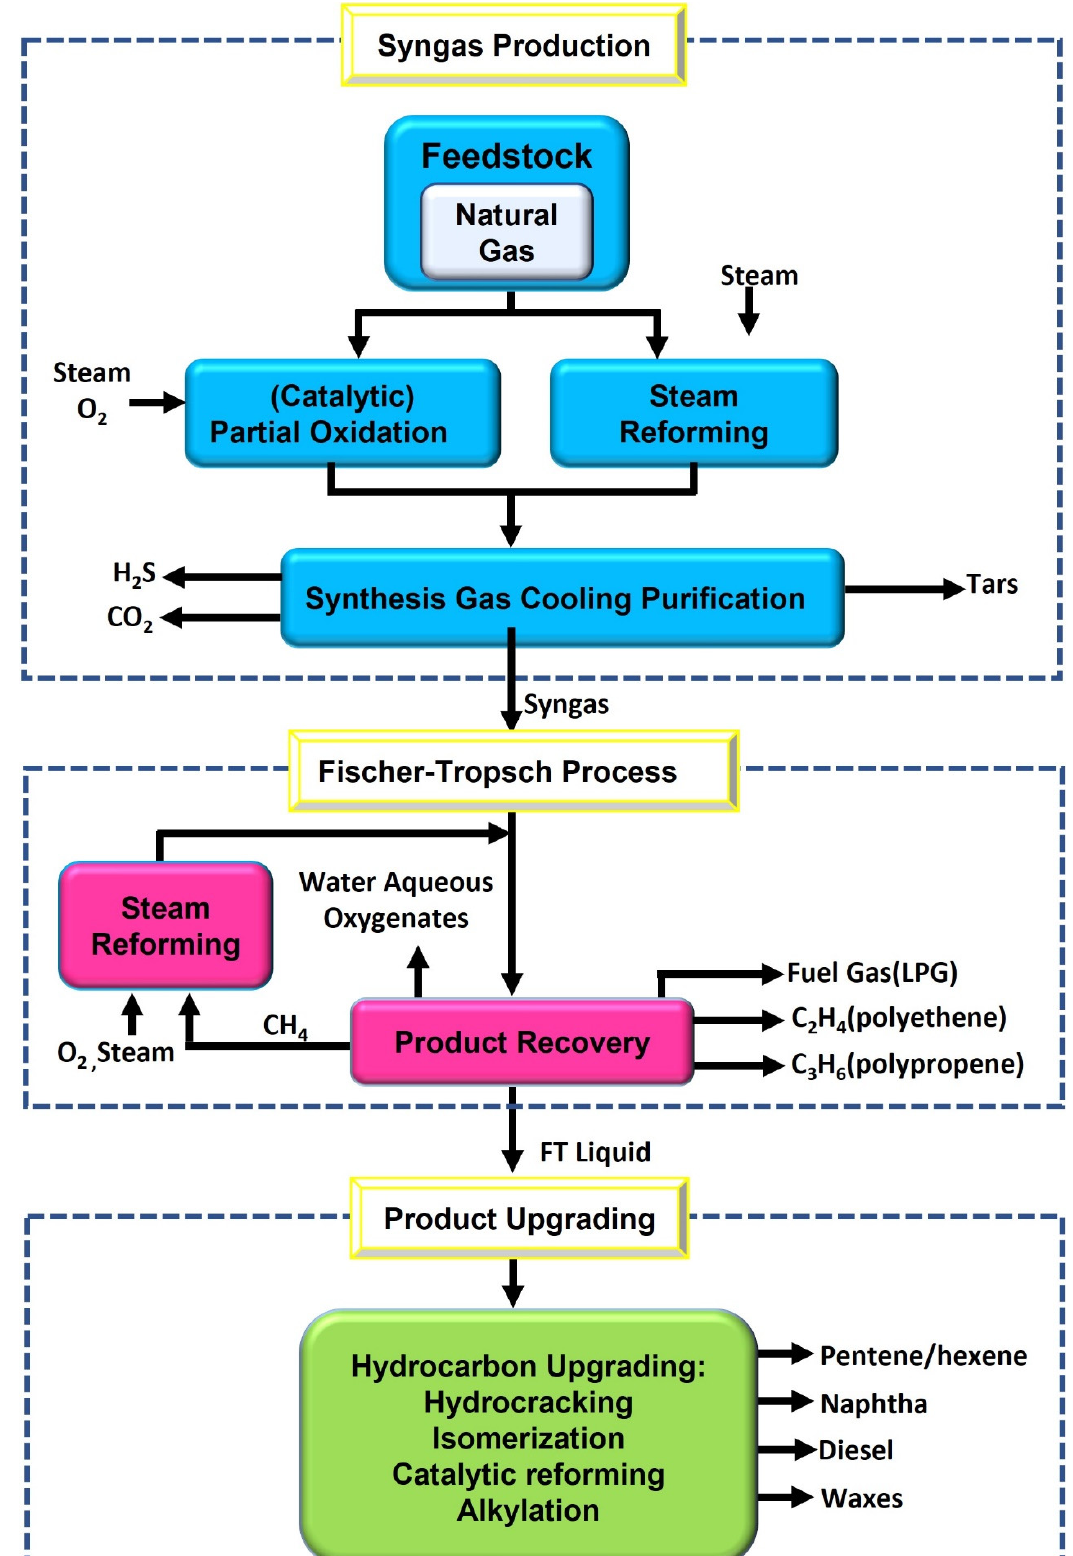
Figure 1. Over all process scheme gas to liquid (GTL) [11,12].